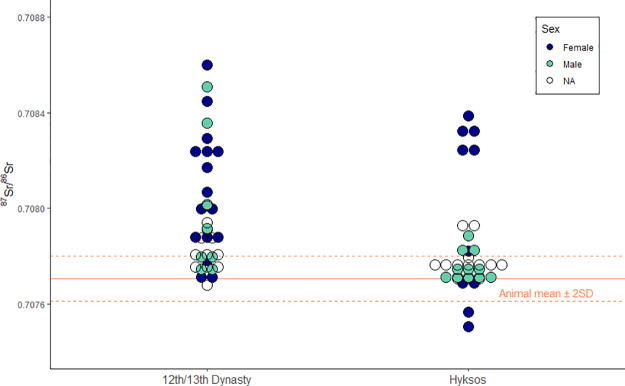
Dot plot showing 87Sr/86Sr results by time period, with the dots colored by sex.